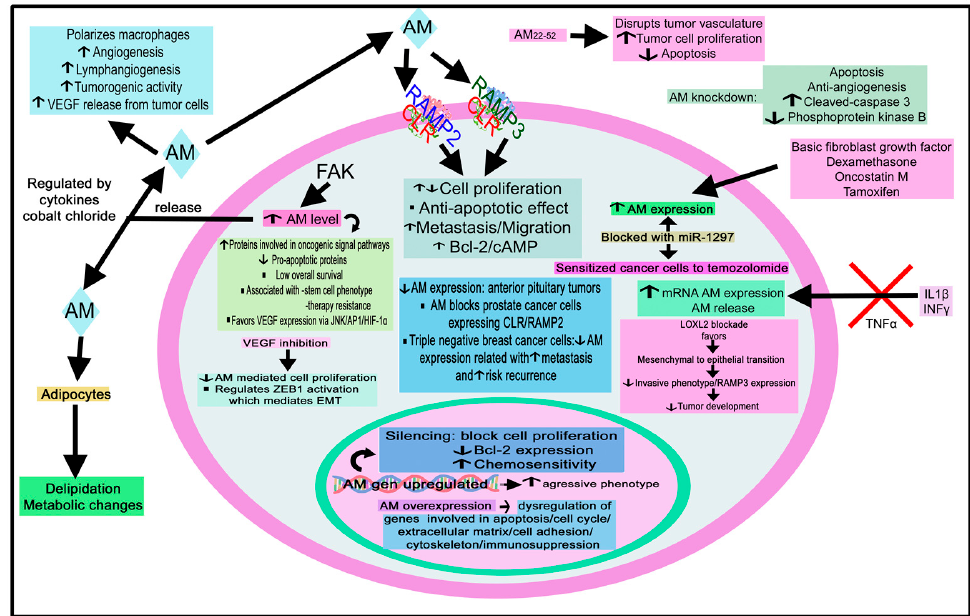
Figure 14. Summary of the mechanisms mediated by adrenomedullin (AM) in tumor cells. AP1: